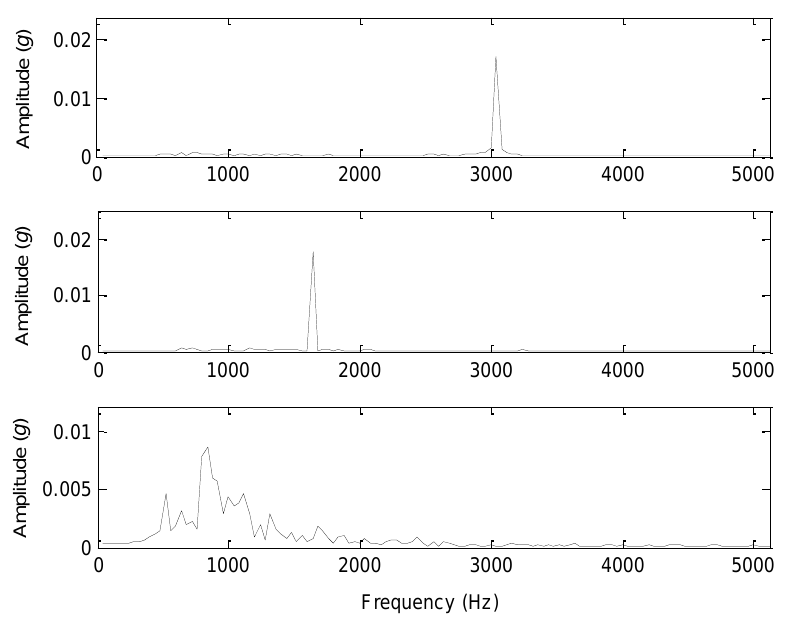
Figure 15. The spectra of the source